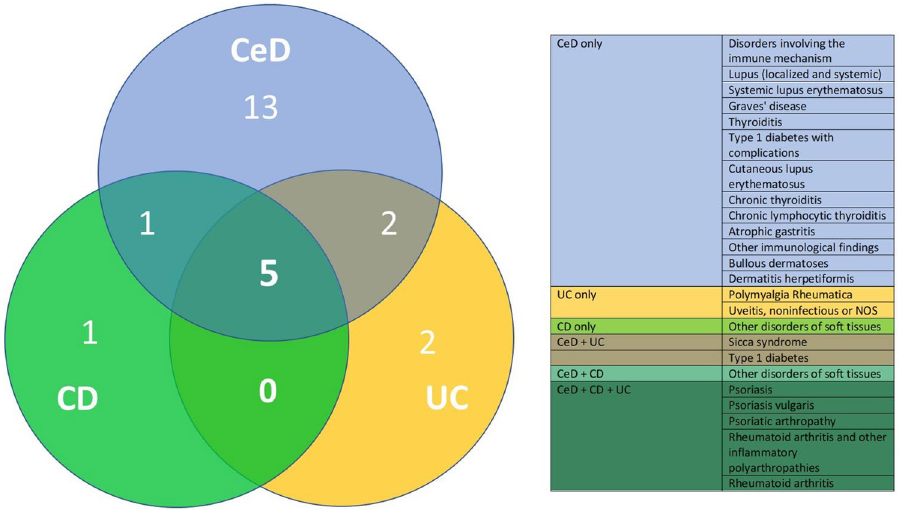
Figure 4. Overview of autoimmune Phecodes associated with the analysed intestinal disorders. Venn diagram depicts the numbers of autoimmune conditions associated with coeliac disease (CeD), Crohn´s disease (CD), and ulcerative colitis (UC). The results are based on the PheWAS analysis comparing the occurrence of all available Phecodes in individuals with the displayed intestinal disorder versus the reference group without any of these intestinal diseases. All conditions are listed in a colour-coded manner in the accompanying table. NOS not otherwise